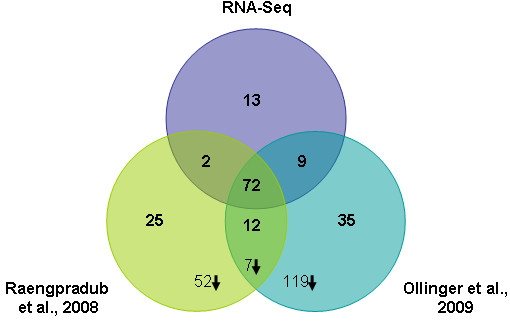
σB-dependent genes identified by RNA-Seq and microarray analyses. Venn diagram of σB-dependent genes identified in stationary phase cells in this study and in previous microarray studies of stationary phase L. monocytogenes [10,12]. Numbers in bold are the number of up-regulated annotated CDS identified as σB-dependent in each study; numbers followed by down arrows are down-regulated σB-dependent genes. No down-regulated σB-dependent genes were identified by RNA-Seq. The 13 genes identified as σB-dependent in stationary phase only by RNA-Seq, but not by previous microarray studies of L. monocytogenes 10403S, include 5 genes that had been found to be σB-dependent, by microarray studies [10] in salt stressed cells (see Table 5). In a number of instances, (e.g. opuCB, rsbX; See Additional file 8: Comparison of genes found to be σB-dependent by microarray analysis and not by RNA-Seq) genes with significantly different transcript levels in both microarrays [10,12] had significant binomial probabilities (q < 0.05) and a fold change ≥ 2.0 for most of the possible combinations (i.e. 10403S replicate 1 vs ΔsigB replicate 1; 10403S replicate 1 vs ΔsigB replicate 2; 10403S replicate 2 vs ΔsigB replicate 1; 10403S replicate 2 vs ΔsigB replicate 2), but not for all four comparisons and these genes were, therefore, not identified as showing significant differences in normalized RNA-Seq coverage (based on our conservative definition of genes with significant differences in normalized RNA-Seq coverage); see Additional file 8: Comparison of genes found to be σB-dependent by microarray analysis and not by RNA-Seq for detailed RNA-Seq data for genes identified as σB-dependent by microarrays, but not by RNA-Seq.